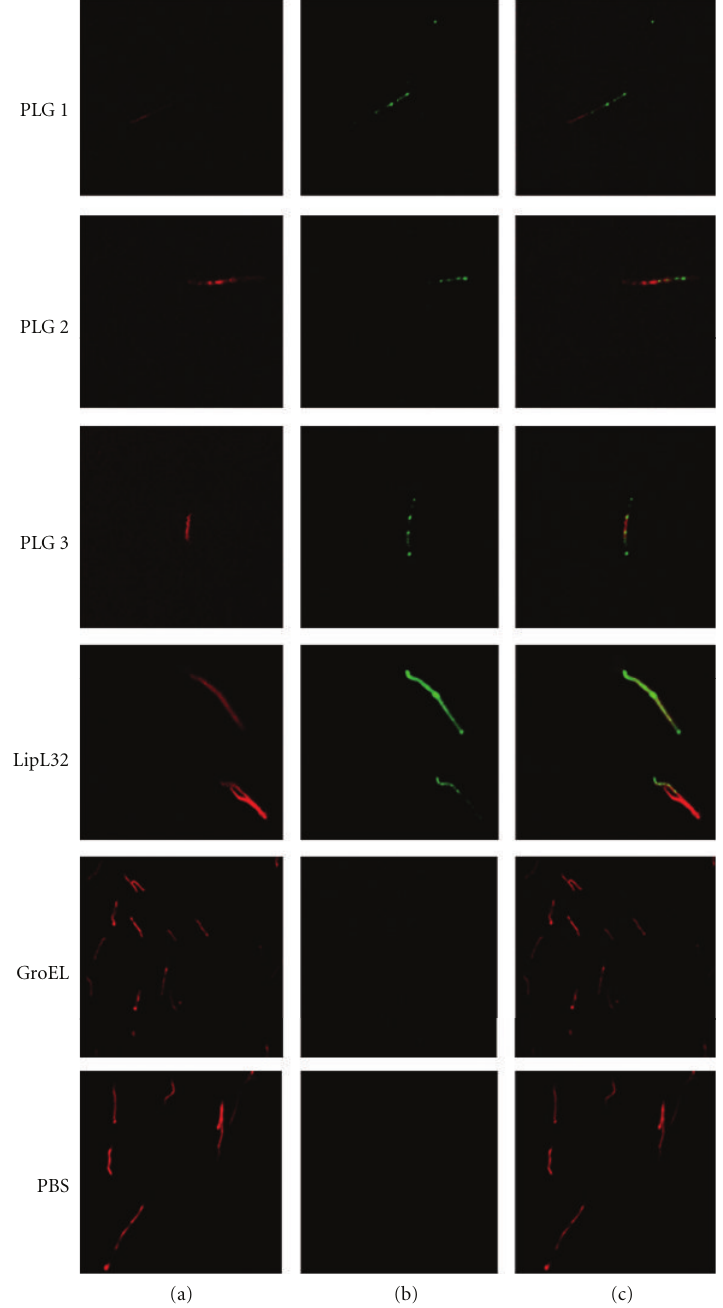
Figure 1: Recognition of PLG binding to Leptospira by L-IFA. Live virulent L. interrogans serovar Copenhageni isolates were treated with PLG, and the recognition was assessed through polyclonal anti-PLG antibodies under a confocal immunofluorescence microscope (PLG 1 to 3). PLG-treated leptospires stained for the proteins LipL32 (outer surface protein marker) or GroEL (a protoplasmic-cylinder marker) and untreated leptospires (PBS), are shown as controls (a) DNA propidium iodide-stained, (b) FITC-stained and (c) A+B composite images. (Calbiochem), followed by secondary antibodies conjugated with peroxidase (1 :